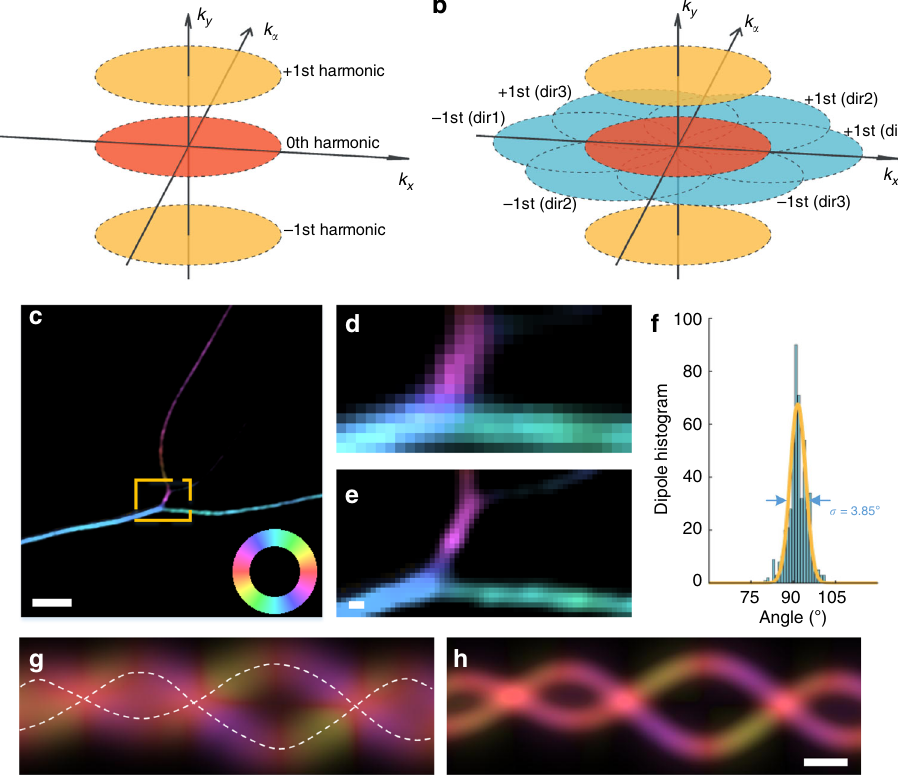
Fig. 2 Comparison between polarization modulation (PM) and pSIM imaging. a The reciprocal space of PM microscopy, including the three harmonics. The zeroth harmonic determines the intensity of the image, while the phases of the fi rst harmonics determine the dipole orientation. b The three directions of structured illumination result in six spatial fi rst harmonics (blue), which make up the reciprocal space of pSIM together with the zeroth harmonic (red) and two angular fi rst harmonics (yellow). c pSIM imaging results of SYTOX orange-labeled DNA fi laments, with the dipole orientations being pseudocolored. The color wheel indicates the relationship between the dipole orientation and the pseudocolor. The dipole orientation of SYTOX orange is inserted perpendicularly into the DNA fi lament. The zoomed-in results in d , e compare the results of PM and pSIM imaging. f A histogram of the dipole orientations in c , where the angle represents the difference between the dipole orientation and the direction of the DNA fi lament. g , h Two simulated fi laments with the dipole orientation tangential to the fi lament. Compared with the PM results ( g ), the pSIM results ( h ) simultaneously show the underlying structure and measure the dipole orientation. Scale bars: c 2 μ m and d – h 200